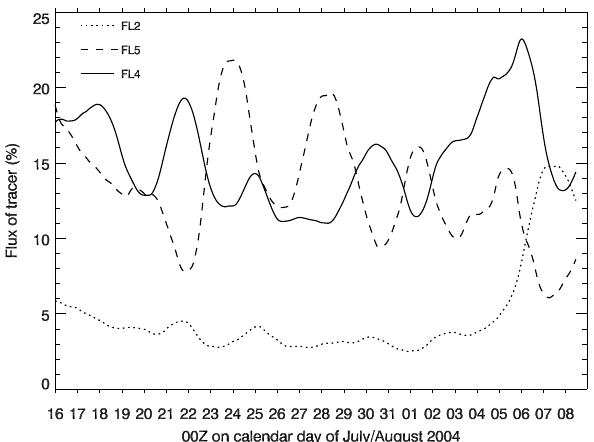
Figure 8. Diurnal cycle in BL heights averaged over the land (solid and uniform decay with a 24-hour lifetime in the MetUM simula- lines) and sea (dashed lines) for the MetUM simulation. Individ- tion. The continental boundary and residual layers (boxes 1 and 3) Fig. 8. Diurnal cycle in boundary layer heights averaged over the ual grey lines represent different days of the MetUM simulation; Figure 7. 24h running average time series of net tracer fluxes from are combined into one box. Numbers in the center each box repre- land (solid lines) and sea (dashed lines) for the MetUM simulation. the thick black lines represent the mean BL height cycles. Time is the continental BL including the residual layer (boxes 1 and 3) sent the average units of tracer residing in each box (plus/minus one presented with respect to Eastern Daylight Time Individual grey lines represent different days of the MetUM simula- Fig. 7. 24 h running average timeseries of net tracer fluxes from the expressed as a percentage of total tracer in the domain, assuming standard deviation) normalised such that the total is 100. The arrows tion, the thick black lines represent the mean boundary layer height quasi-stationary masses. Mass transport into the MBL, F L 2 (dot- continental boundary layer including the residual layer (boxes 1 and indicate the direction of net mass transport between boxes and the Fig. 5. A schematic of the 6-box partition used to analyse tracer cycles. Time is presented with respect to Eastern Daylight Time ted), into the coastal outflow layer, F L 4 (solid) and vertically into 3) expressed as a percentage of total tracer in the domain, assuming numbers and width of each band represent the amount transported transport in the MetUM simulation, which subsequently forms the (UTC-4). the free troposphere, F L 5 (dashed). along the related pathway in order to maintain steady state. Light quasi-stationary masses. Mass transport into the marine boundary basis of a box model. H and H are the heights of the continen- MBL grey arrows are estimates of transport by convection, and dark grey layer, F (dotted), into the coastal outflow layer, F (solid) and tal and marine boundary layers respectively. H is the maximum L 2 L 4 max for advection and turbulent mixing. vertically into the free troposphere, F (dashed). height of the continental boundary layer, defining the top of the L 5